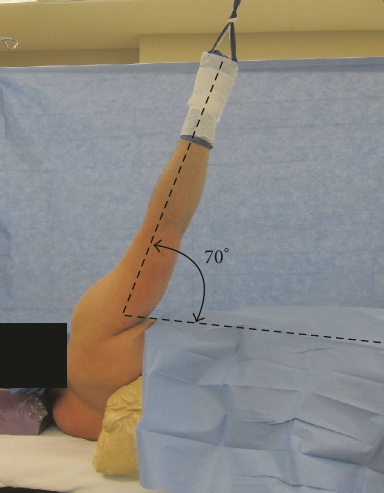
Figure 2: Recreation of the setup used in the patients in this report demonstrating 0 ∘ of flexion and 70 ∘ of abduction.